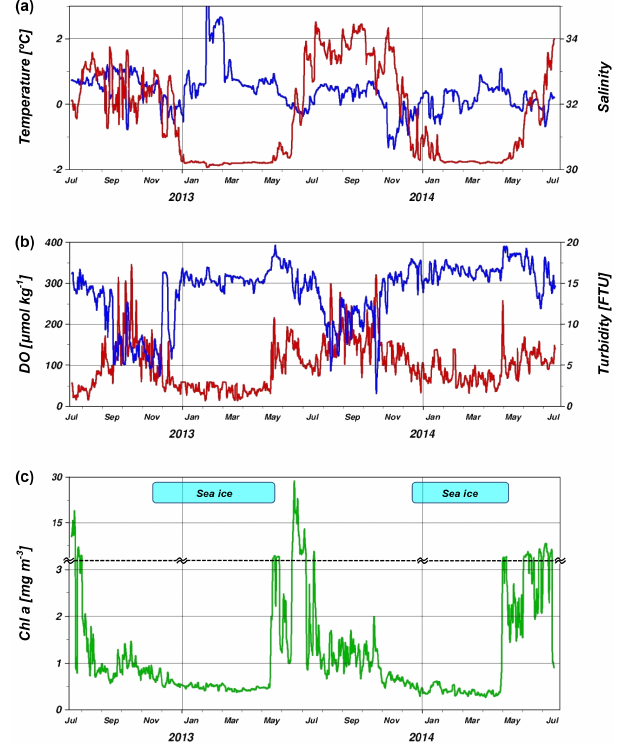
Figure 2. Time series of (a) temperature ( ◦ C; red) and salinity (blue), (b) dissolved oxygen, DO, (µmolkg − 1 ; blue) and turbid- ity (in Formazin Turbidity Units, FTUs; red), and (c) chlorophyll a , Chl a , (mgm − 3 ; green). The data were obtained from the SCH- 12, SCH-12-2, and SCH-13 moorings during 16 July 2012–19 July 2014. The vertical axis scale in (c) below the dotted line is exagger- ated where the concentration is <3mgm − 3 . Periods when sea ice concentration was >50% at the mooring site are indicated by blue